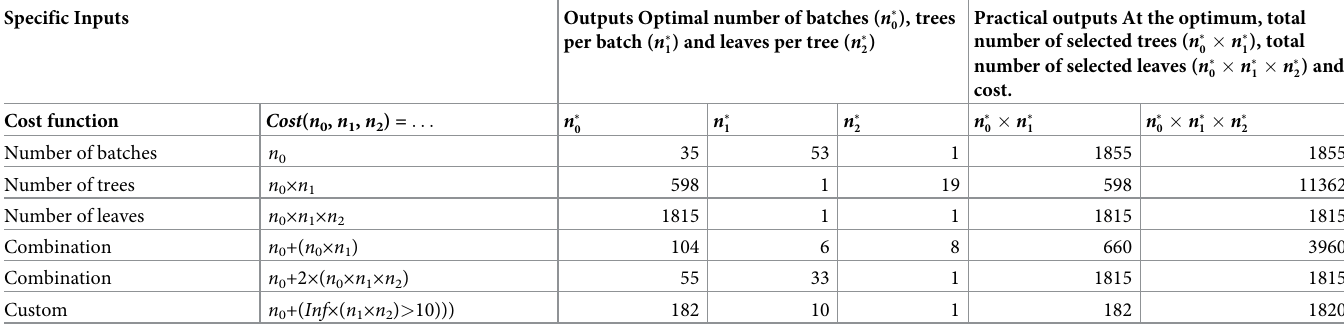
Table 3. Optimal sample sizes for different cost functions. Specific